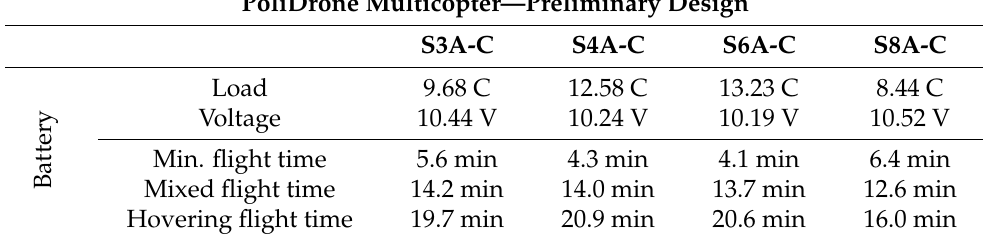
Table 10. Preliminary design of PoliDrone multicopter: battery performance estimations. Calcula- tions are based on a 6000 mAh, 11.1 V battery used up to